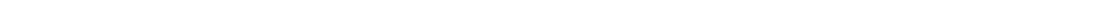
Fig. 1 The number of ubiquitin moieties encoded by the eukaryotic polyubiquitin gene is evolutionary unstable and varies among species and strains. a The eukaryotic polyubiquitin gene (e.g., UBI4 ) is transcribed as a single transcript and translated into a multiunit ubiquitin precursor that is subsequently cleaved into free ubiquitin moieties by speci fi c deubiquitinating enzymes. b Phylogenetic tree of various eukaryotic model organisms ( left ) and their polyubiquitin gene structure(s) ( right ). The variant containing the highest number of ubiquitin repeats is drawn (except for D. melanogaster ). The gene names for each homologue in the Uniprot database are given. The polyubiquitin gene underwent a duplication event in several eukaryotic lineages (extra gene copy represented in blue ). In the D. melanogaster lineage, the duplicated copies are in tandem. c Boxplot depicting the variation in polyubiquitin repeat number for various eukaryotic model organisms (see also b and Supplementary Data 1). d The polyubiquitin UBI4 gene was ampli fi ed from 98 strains belonging to the Saccharomyces genus in their natural ploidy. Shown are 48 representative strains. The framed section shows the ampli fi cation products of the different UBI4 gene variants constructed for this study in the Saccharomyces cerevisiae S288c lab strain, with the number under the lanes indicating the number of UBI4 repeats. Asterisks denote the products of DNA ampli fi cation and Southern blot ( e ) of the UBI4 gene originating from the same strains. e Southern blot analysis con fi rms the number of UBI4 repeats in a subset of the natural strains ( d ), and rules out that the differences in UBI4 length or the multiple bands shown in c are due to slippage during PCR ampli fi cation. Asterisks denote the products of DNA ampli fi cation and Southern blot of the UBI4 gene originating from the same strains. f Distribution of UBI4 repeat number in the Saccharomyces genus. The UBI4 allele of 2 units is always heterozygous with the other allele being ≥ 4